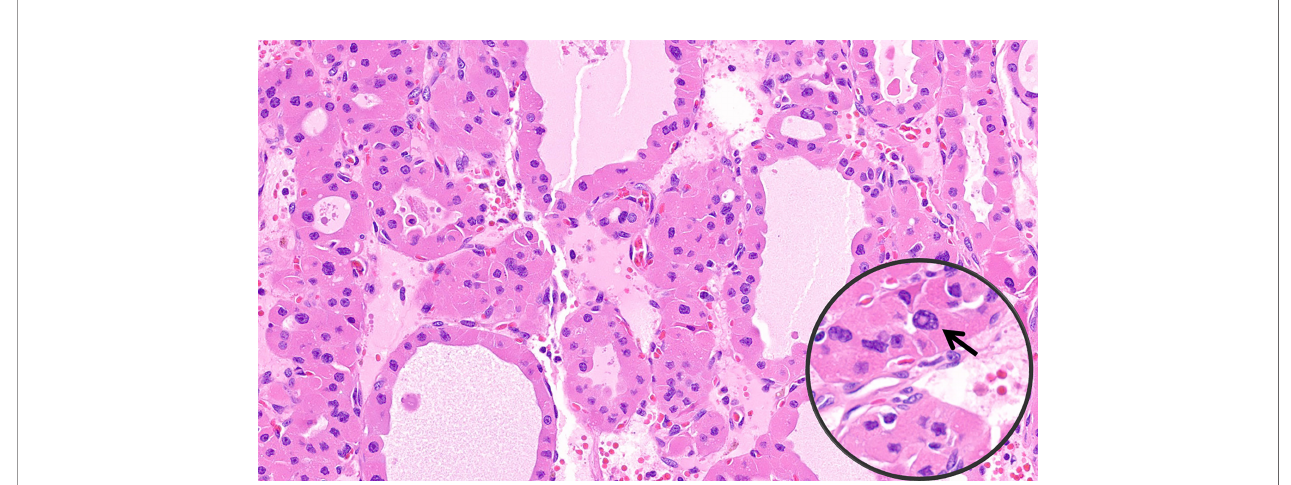
FIGURE 2 | Oncocytic follicular variant papillary thyroid carcinoma. These tumors are oncocytic follicular cell-derived neoplasms that exhibit exclusive follicular architecture along with nuclear features of papillary thyroid carcinomas in the absence of classic architecture, solid growth (>30%), tumor necrosis or increased mitotic activity. The nuclear alterations of papillary thyroid carcinoma are characterized by nuclear membrane irregularities in enlarged nuclei. The inset illustrates an intranuclear